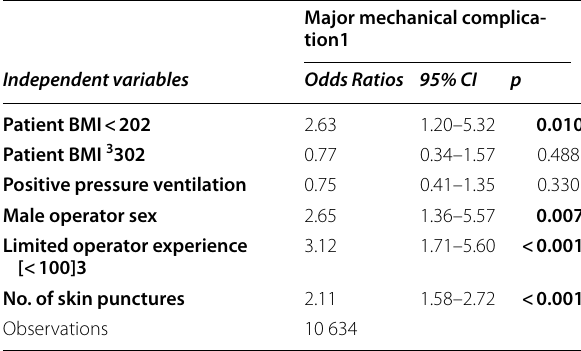
Table 1. Multivariable logistic regression analysis for major mechanical